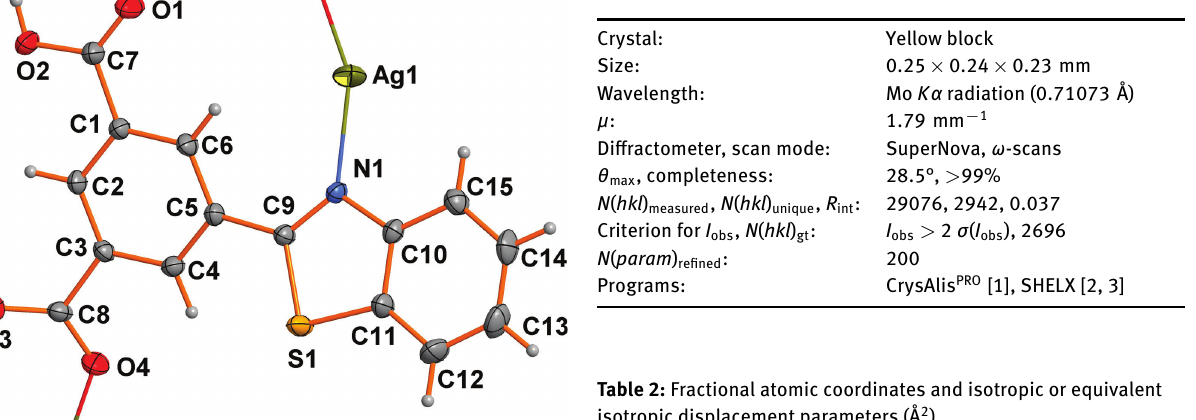
Table 1: Data collection and handling.